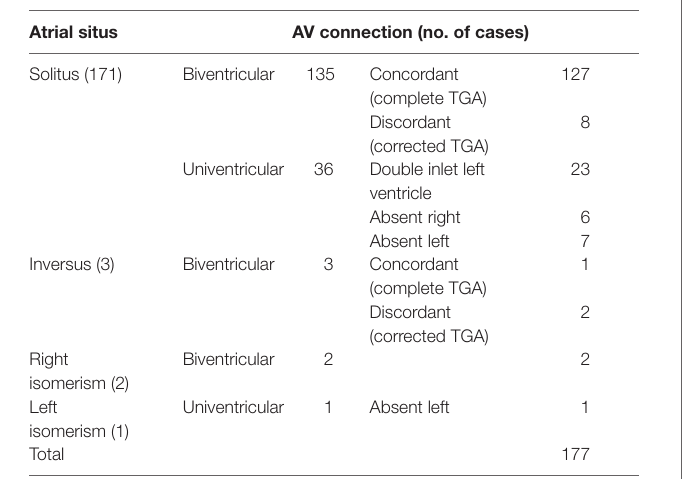
TaBle 1 | Discordant Va connection: atrial situs and aV connections.